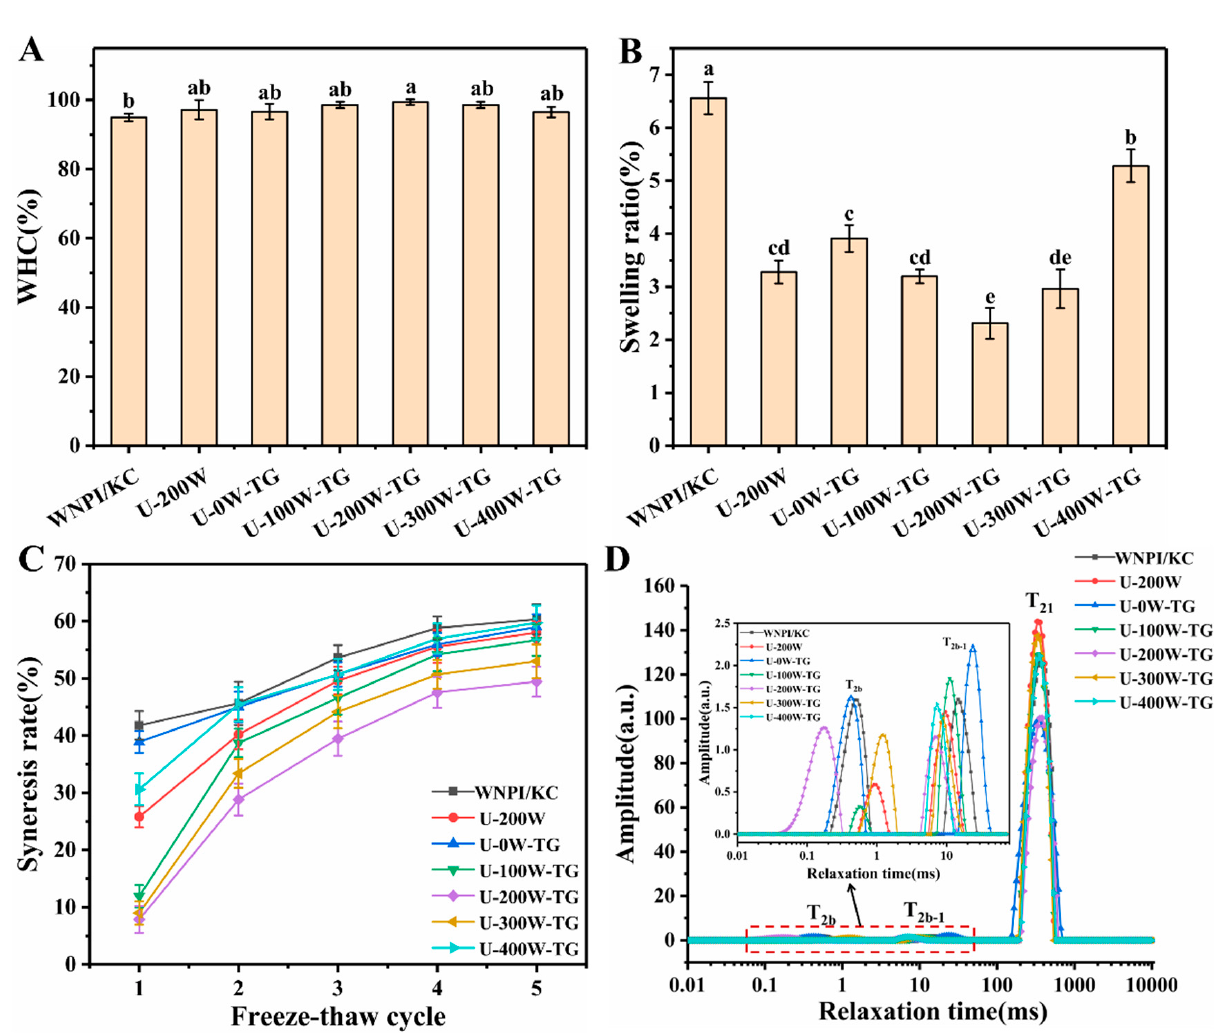
Figure 1. Effects of ultrasonic power on WHC ( A ), swelling ratios ( B ), freeze–thaw cycles ( C ) and moisture distribution ( D ) of WNPI-KC composite gels. Different letters on the bars indicate significant differences ( p < 0.05).